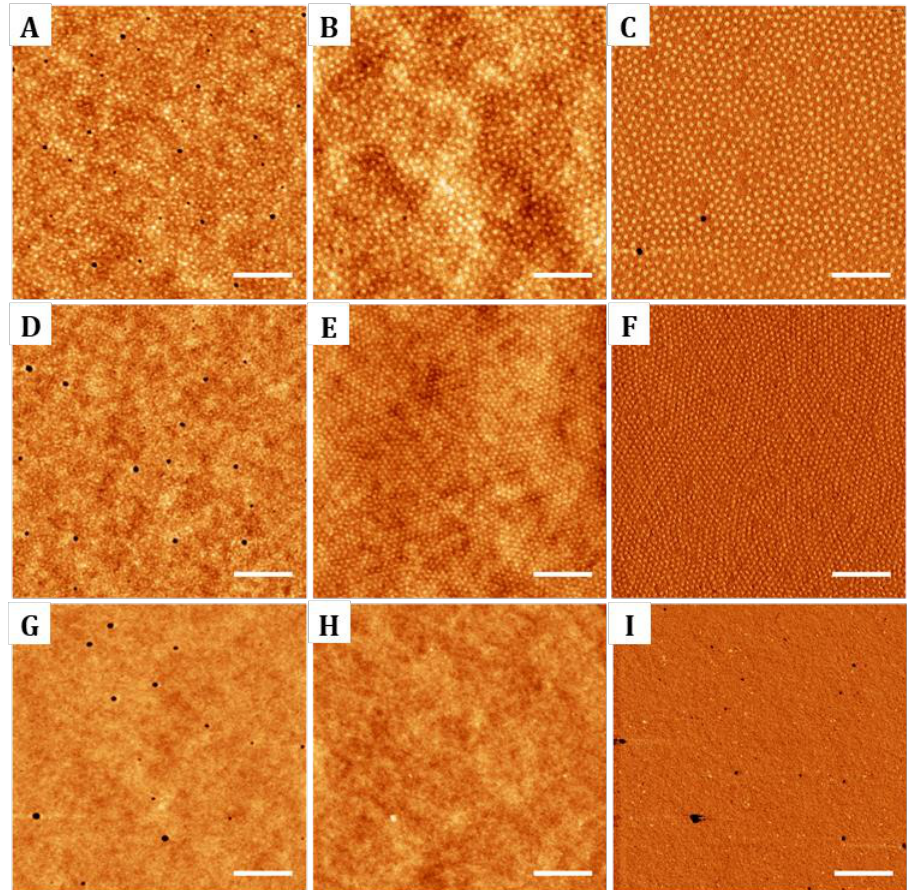
Figure 1. Atomic force microscopy (AFM) images illustrating the topography of thin films of diblock copolymers poly(styrene) (PS)-b-poly(methyl methacrylate) (PMMA) 123-35 (7.5 mg/mL, first row), PS-b-PMMA 46-21 (5 mg/mL, second row) and random copolymer PS-r-PMMA (5 mg/mL, third row). For diblock copolymers, films did not look ordered just after deposition ( A , D ) and formed hexagonal patterns after 3 h of thermal annealing at 220 °C: ( B , E ) show the sample topography and ( C , F ) the corresponding AFM phase images. Panel ( G ) shows the morphology of the random copolymer before annealing, ( H ) corresponds to the topography after annealing and ( I ) is the corresponding phase image. Scale bar 400 nm; Z-scale: 5 nm.